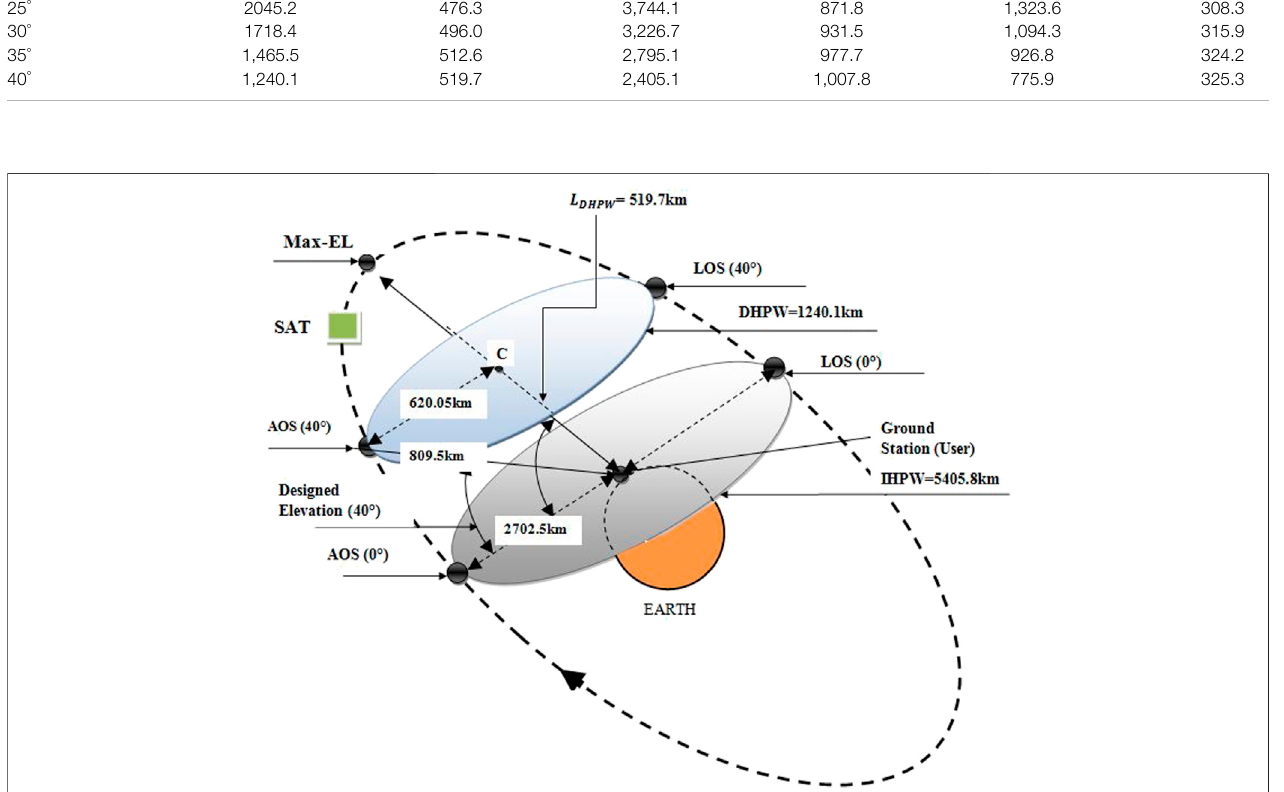
FIGURE 5 | IHDW, DHPW, d max , and L DHPW dimensions for H (cid:1) 550